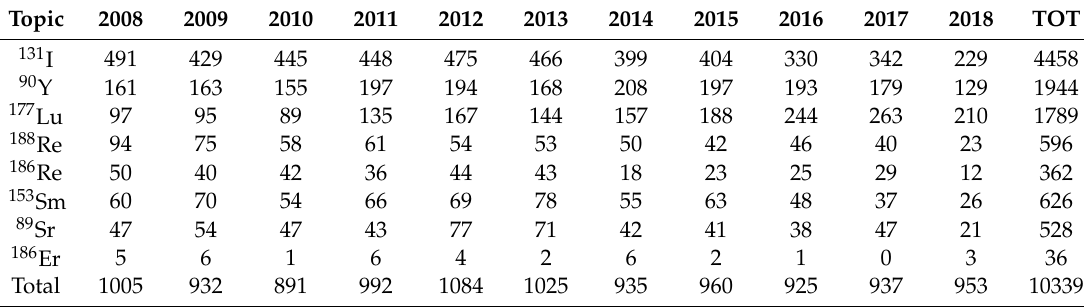
Figure 2. Graphical representation of the annual publications discussing CRNs (2008–2018).